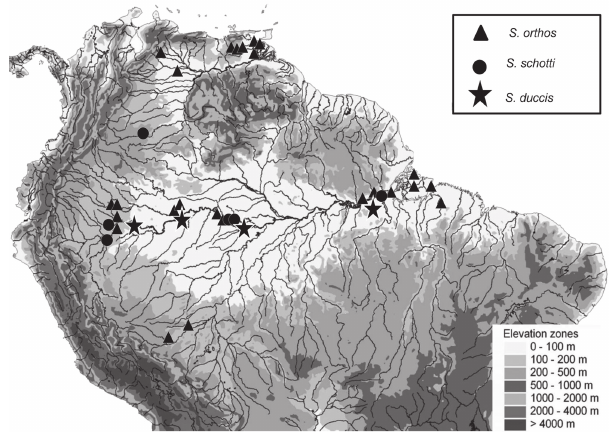
Fig. 17. Map of collection localities of S. orthos (triangles), S. schotti (circles), and S. duccis (stars). Note these three species are broadly sympatric throughout the Eastern and Western Amazon, with S. orthos also present in the upper Madeira and Lower Orinoco, and S. schotti known from a single specimen in the Meta River, Orinoco basin. Note also, S. orthos is represented at more sites than S. schotti